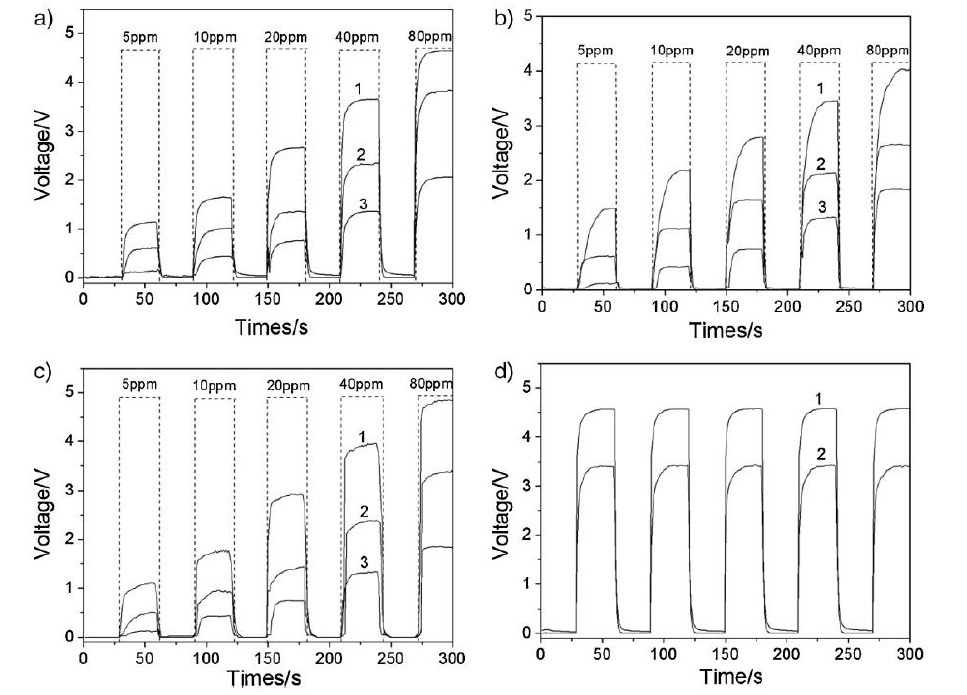
Figure 10. Typical response curves of 14-faceted polyhedral (line 1) and octahedral (line 2) ZnSnO and ZnSnO powder (line 3) gas sensors to (a) H 3 3 (c) C H OH with increasing concentrations. (d) The response curves of 14-faceted 2 5 polyhedra (line1) and octahedra (line 2) to H S (70 ppm) at room temperature (adapted 2 from